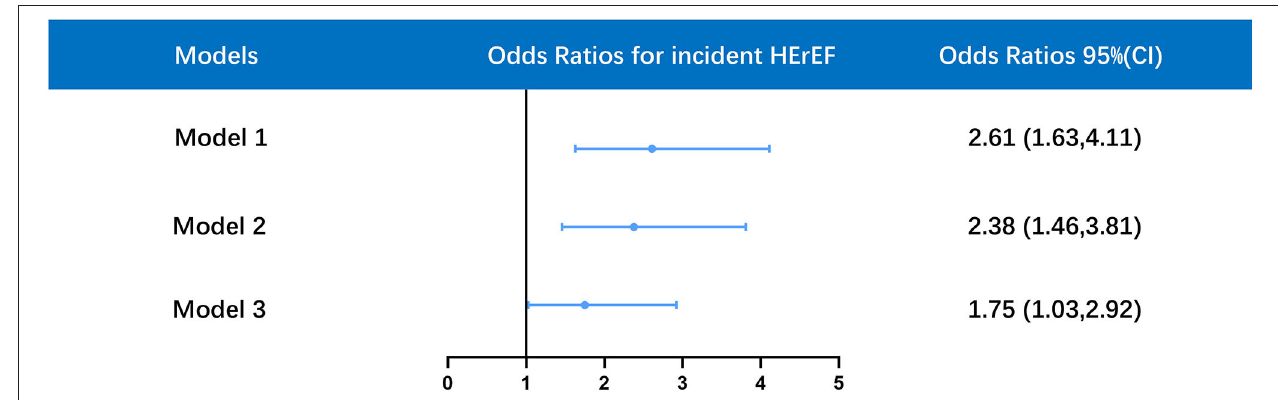
FIGURE 3 | Multivariate logistic regression analysis for association between HFrEF and CKD in different models. Model 1 was unadjusted; model 2 was only adjusted for age and gender; model 3 was adjusted for age, gender, diabetes mellitus (DM), hypertension, atrial fibrillation (AF), congestive heart failure (CHF), baseline left ventricular ejection fraction (LVEF), angiotensin-converting enzyme inhibitor/angiotensin receptor blocker (ACEI/ARB), statins. OR, odds ratios; CI, confidence interval. (ROC: AUC = 0.844, Hosmer-Lemeshow goodness-of-fit test: P =